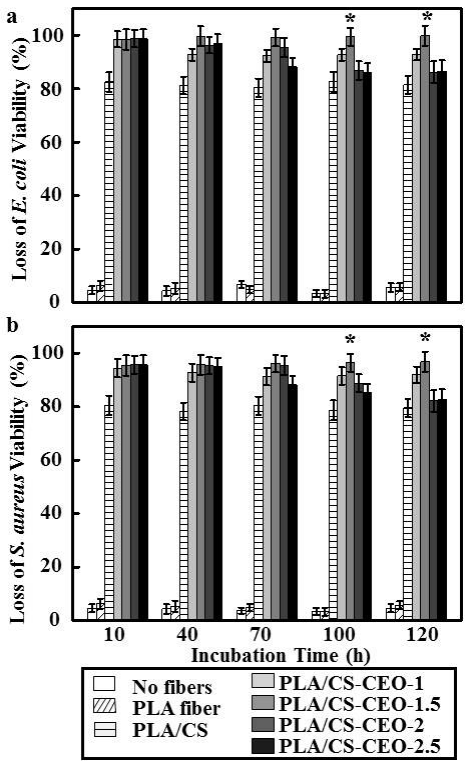
Figure 7. The loss of ( a ) E. coli and ( b ) S. aureus viability of incubation time for PLA, PLA/CS, and PLA/CS-CEO electrospun fibers. ( n = 5, * means p <